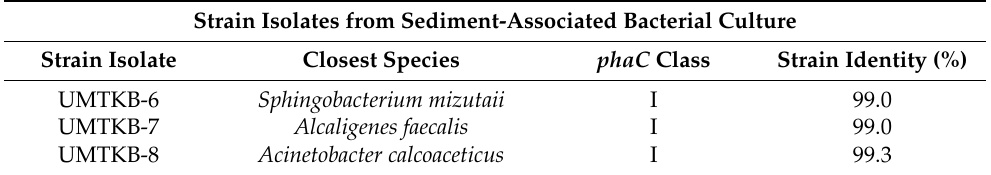
Table 3. PHA synthase ( phaC ) genes identified from strain isolates from sediment-associated bacteria. Strain Isolates from Sediment-Associated Bacterial Culture Strain Isolate Closest Species phaC Class Strain Identity (%) UMTKB-6 UMTKB-7 Alcaligenes faecalis I 99.0 UMTKB-8 Acinetobacter calcoaceticus I